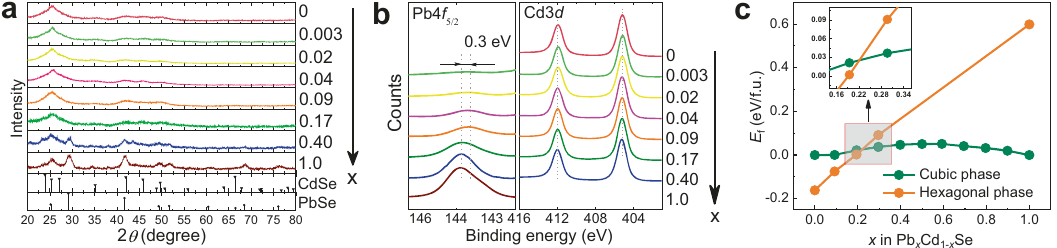
Fig. 3 Structural characterization of Pb x Cd 1 − x Se QD gels and related machine learning (ML) simulation. a PXRD patterns of Pb x Cd 1 − x Se QD gels with x = 0.003, 0.02, 0.04, 0.09, 0.17, 0.40, and 1.0. The stick diagrams show the PXRD patterns of hexagonal CdSe and cubic PbSe as references. b XPS results of the Cd3 d and Pb4 f 5/2 regions for the QD gels. c Calculated thermodynamic convex hull diagram of Pb x Cd 1 − x Se in cubic and hexagonal phases with respect to cubic PbSe and cubic CdSe using the converged ML surrogate model (Supplementary Fig. 10). Note that the Pb x Cd 1 − x Se hexagonal supercells at x > 0.3 were unstable with severe deformation during DFT calculations; therefore, we only considered the Pb x Cd 1 − x Se hexagonal supercells with x = 0, 0.1, 0.2, 0.3, or 1.0. The inset shows the expanded view of the crossover